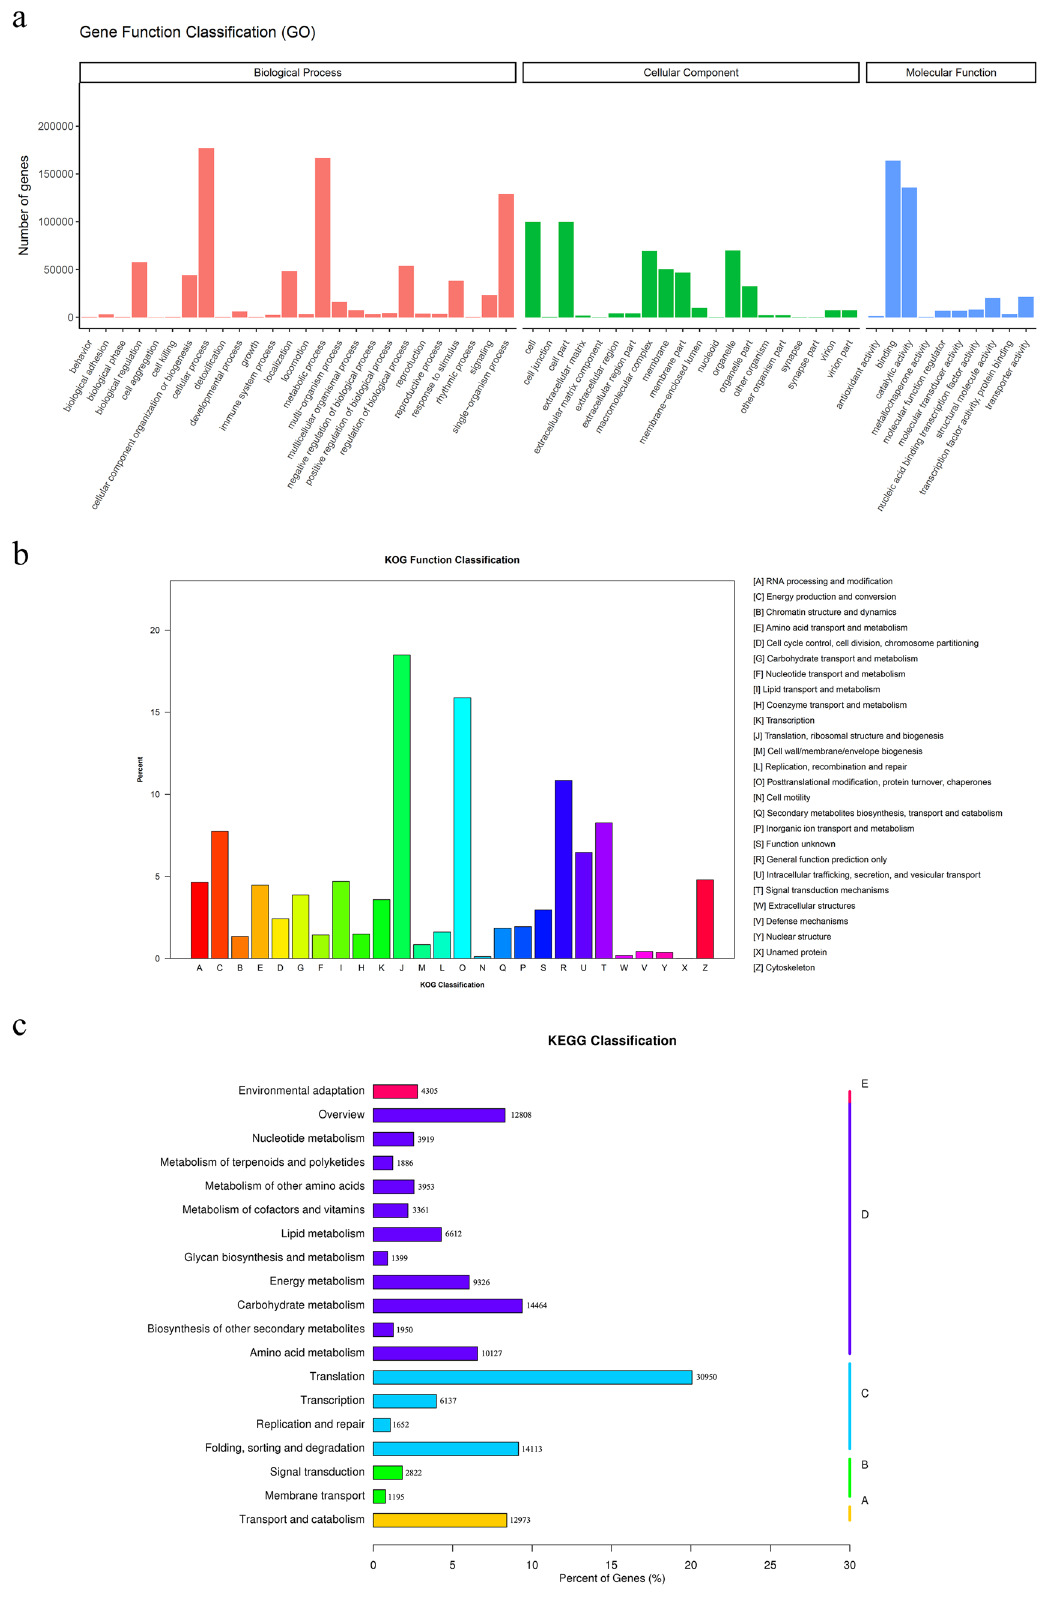
Figure 1. Gene ontology classification of assembled unigenes ( a ). KOG function classification of assembled unigenes ( b ). Functional classification and pathway assembled unigenes by KEGG ( c ); The A–E indicates Cellular Processes, Environmental Information Processing, Genetic Information Processing, Metabolism, Organismal Systems,